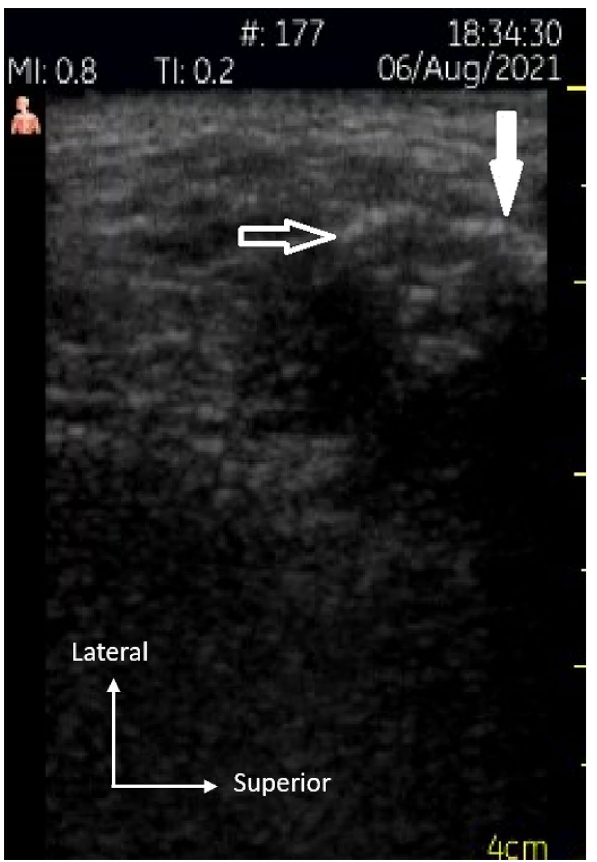
Figure 4. Hyaluronic acid filling the lower compartment over the articular surface (white arrow) and lateral infundibulum (outlined arrow).